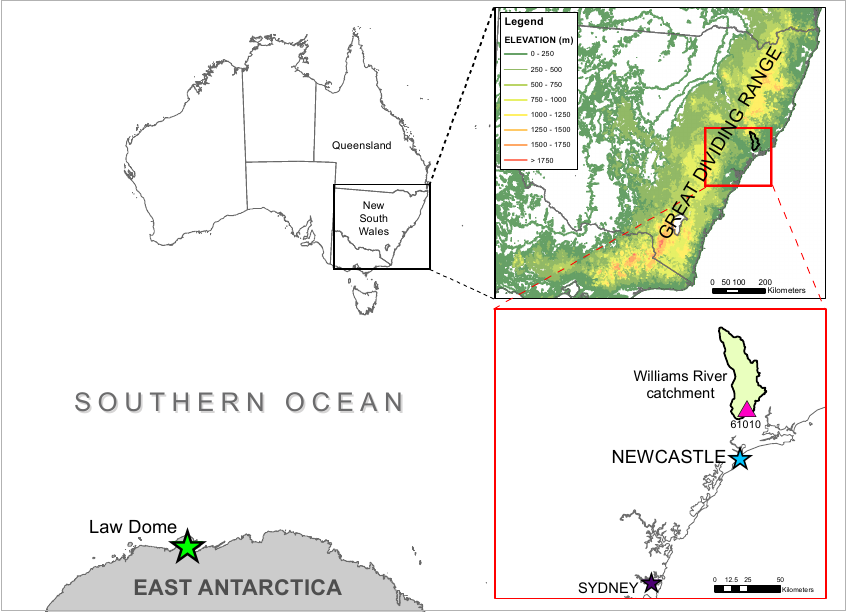
Figure 1. Location of Law Dome in relation to Australia with insets indicating the Great Dividing Range, WR catchment boundary and the location of the 61010 high-quality rainfall gauge, Newcastle and